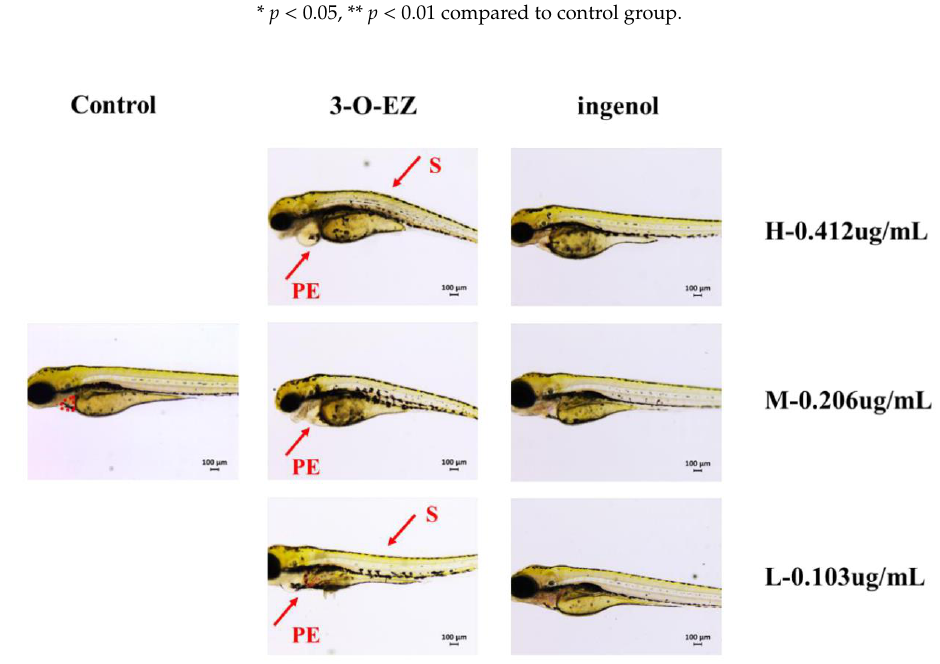
Table 1. The result of heart rate and SV-BA value in zebrafish embryos (mean ± SD, n = 10). Group Concentration ( µ g / mL) Heart Rate SV-BA